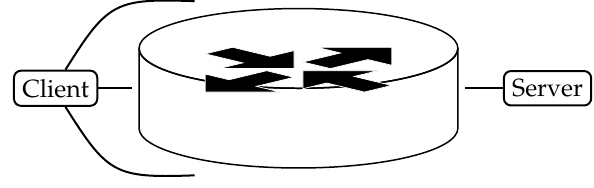
Figure 4. Network